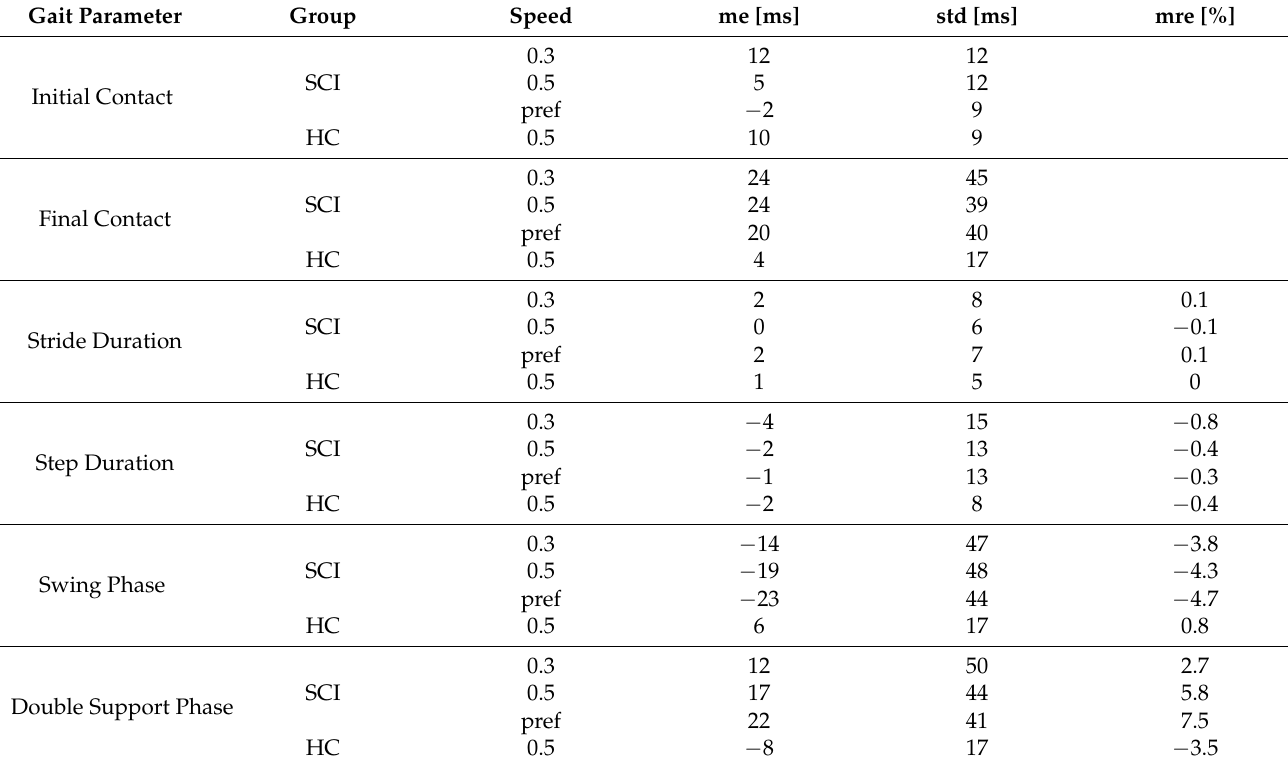
Table A1. Mean error (me), its standard deviation (std), and the mean relative error (mre) between the temporal gait parameters derived from the GRAIL and the inertial sensors. The values are reported for SCI patients and healthy controls (HC) and the speed levels of 0.3 m/s, 0.5 m/s, and preferred (pref) walking